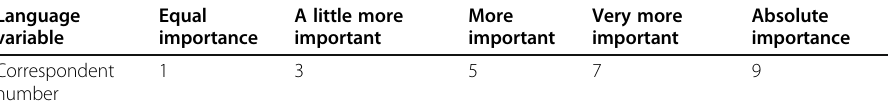
Table 9 Language variables and correspondent number for determining the relative importance Language variable